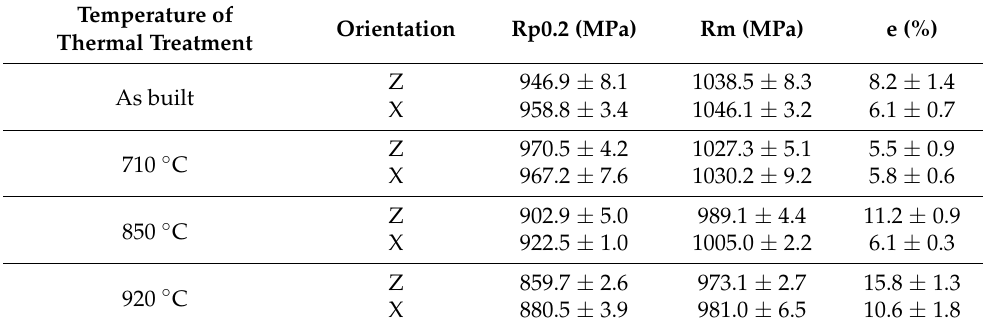
Table 3. Mechanical properties (Rp0.2: yield strength, Rm: ultimate tensile strength, e: elongation) achieved for both orientations for WAAM parts treated at different temperatures.